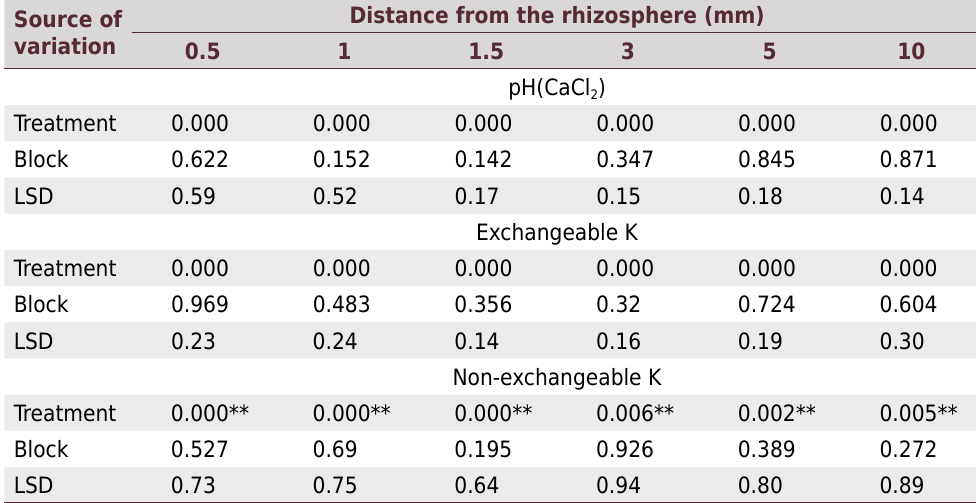
Table 3. Summary of the ANOVA results (p value) and LSD for pH(CaCl 2 ), exchangeable and non- exchangeable K as affected by soil treatments within each distance from the U. ruziziensis rhizosphere